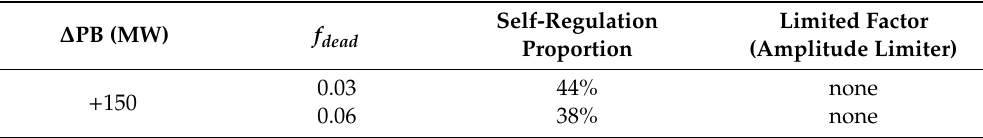
Table 5. The self-regulation proportions of power fluctuations (different f dead ).